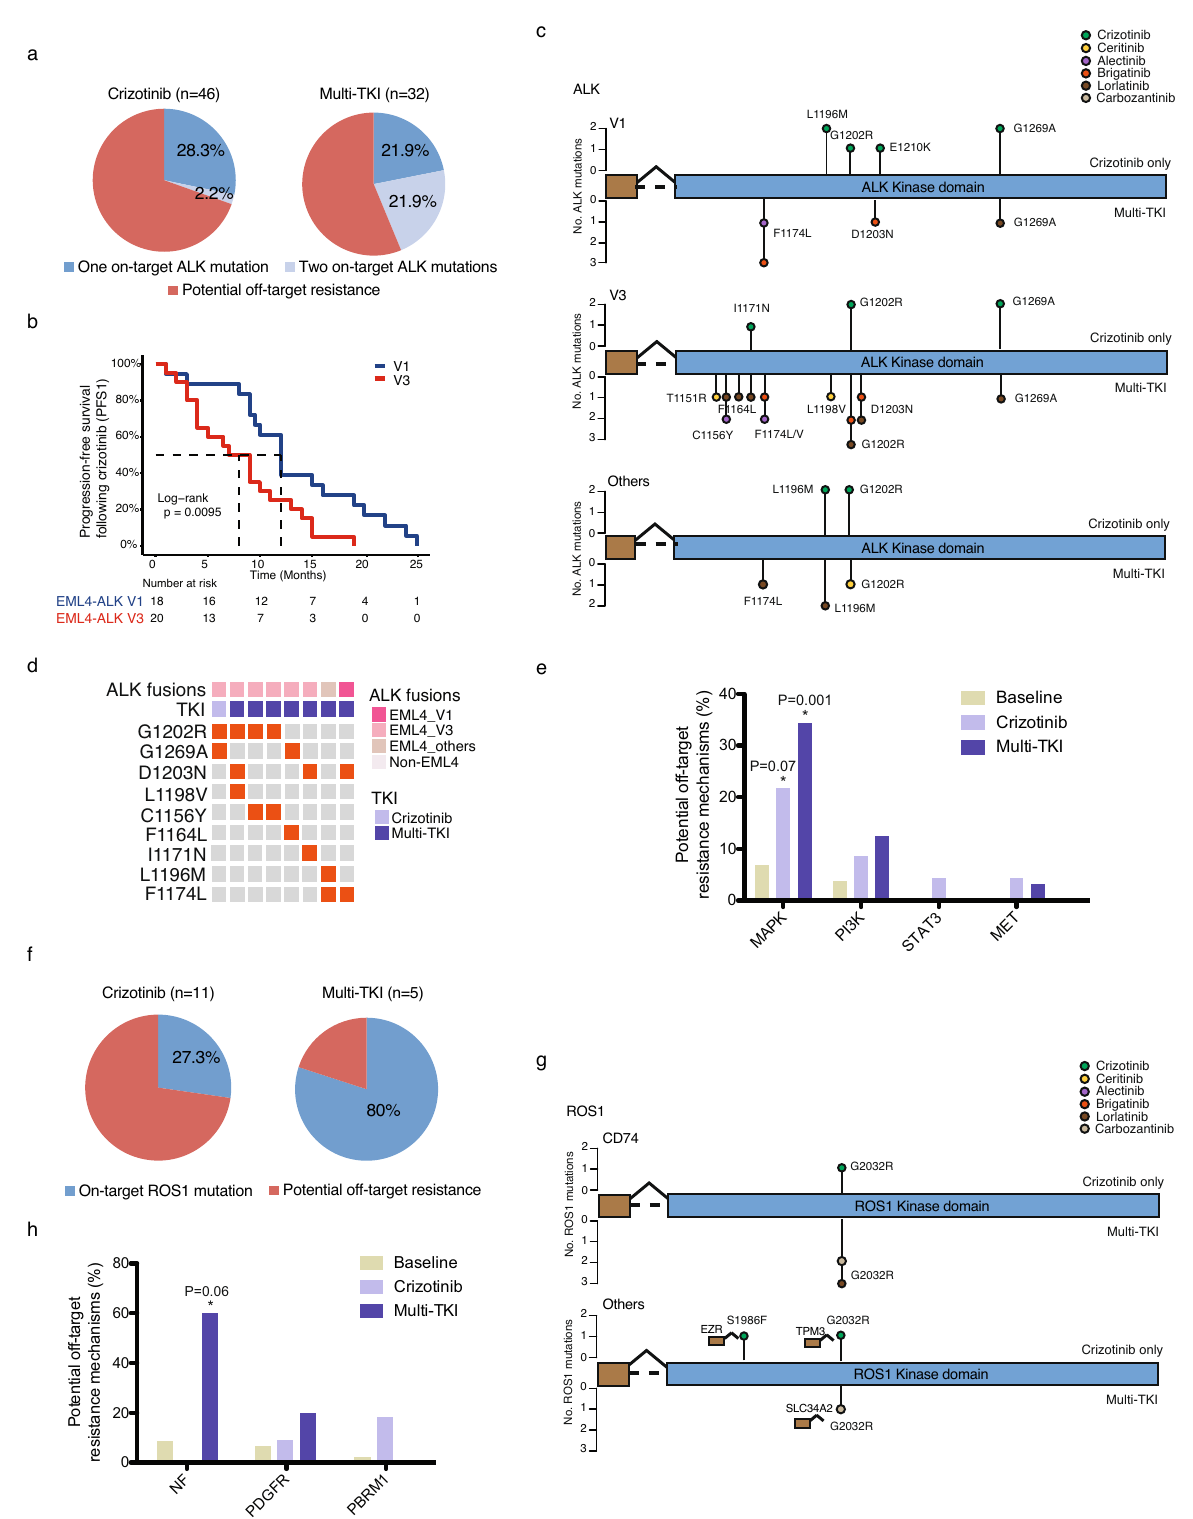
Fig. 4 Potential resistance mechanisms in ALK and ROS1 patients following TKI treatment. a Proportions of patients carrying on-target ALK resistance mutations following ALK TKI treatment. b Kaplan – Meier estimates of PFS comparing patients with the two major EML4 - ALK variants following fi rst-line crizotinib. c Lollipop plots mapping the on-target resistance mutations in different ALK fusion variants following crizotinib or multi-TKI treatments. d Resistance mutations in patients who acquired multiple on-target ALK mutations following TKI treatment. e Potential off-target resistance mechanisms of ALK fusions (MAPK pathway included EGFR , NF1 / 2 , BRAF , RAF1 , KRAS , and NRAS mutations; PI3K pathway included PIK3CA , PTEN , AKT2 , and RICTOR mutations). f Proportions of patients carrying on-target ROS1 resistance mutations following TKI treatment. g Lollipop plots mapping the on-target resistance mutations in different ROS1 fusion variants following crizotinib or multi-TKI treatments. h Potential off-target resistance mechanisms of ROS1